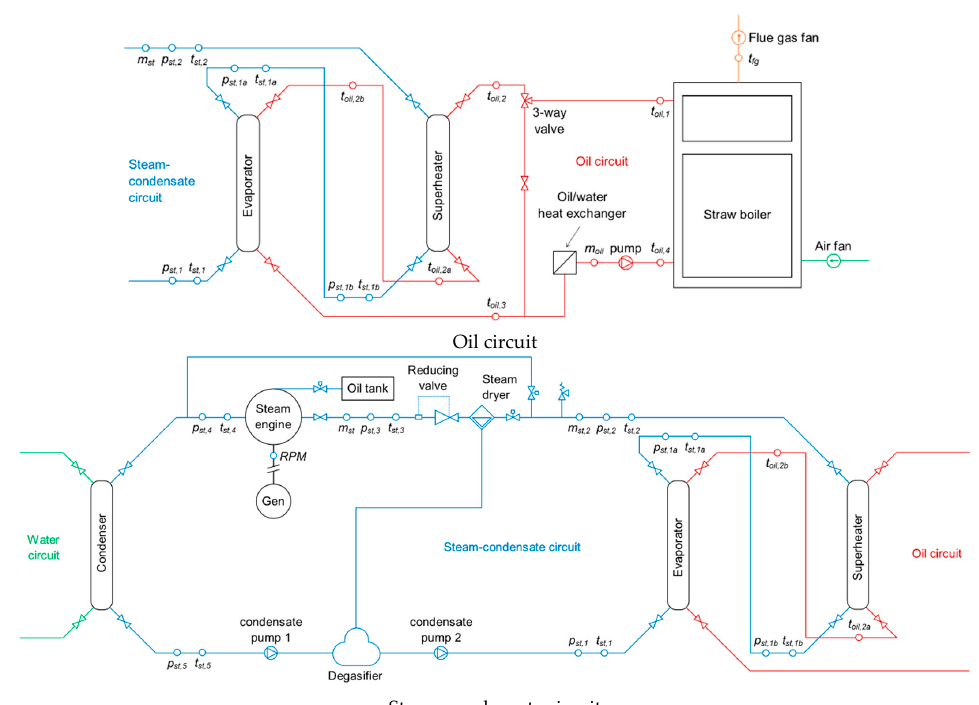
Figure 5. The simplified schemes of the oil circuit and steam-condensate circuit.